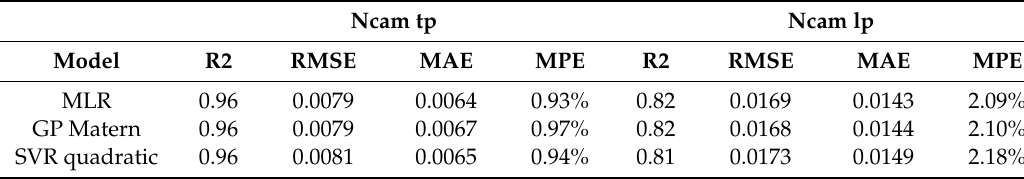
Table 2. The performances of Ncams on NDVI estimation with di ff erent models.